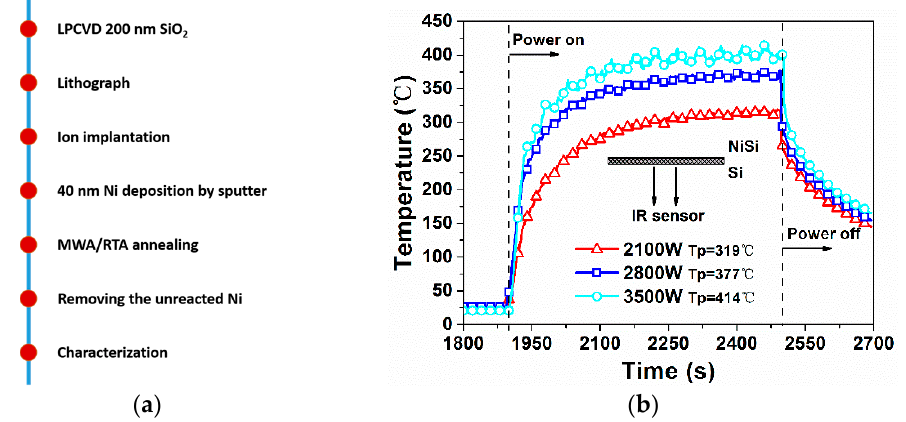
Figure 1. ( a ) Process flow; ( b ) temperature profiles of the MWA processes performed at different microwave powers.